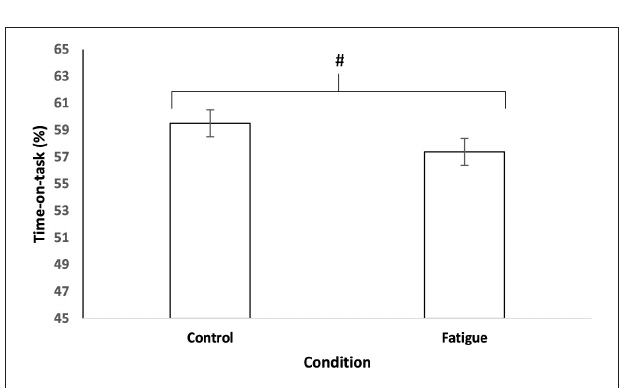
FIGURE 3 | Task execution. Percent time-on-task completed as a function of cognitive fatigue or control. # Significant main effect for condition ( p < 0.05). Data are presented as mean ±